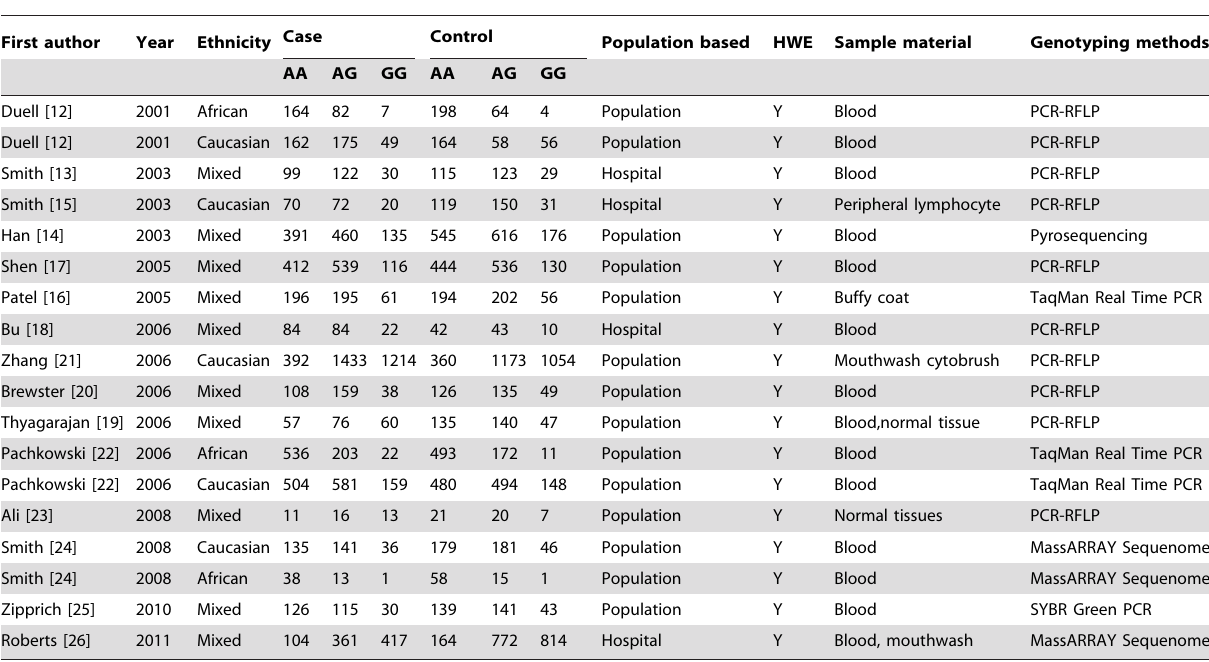
Table 1. Characteristics of included studies in this